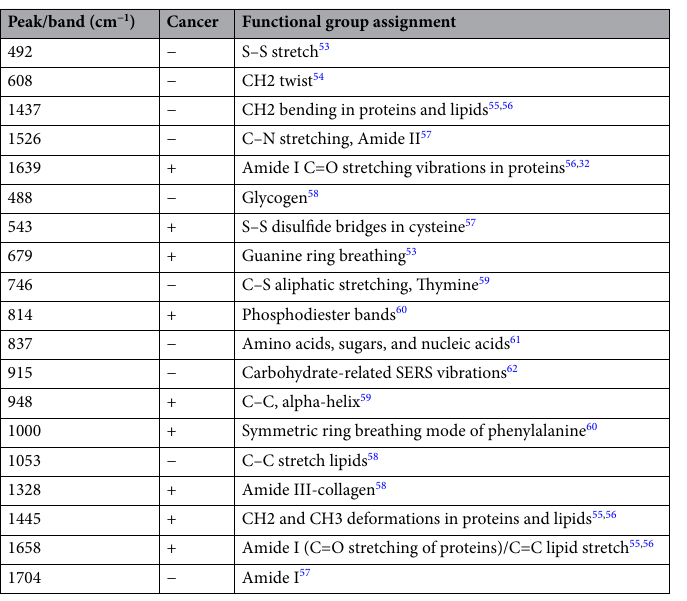
Table 2. Raman peaks of interest with characteristics in cancer samples (increased or decreased), with assigned functional groups.